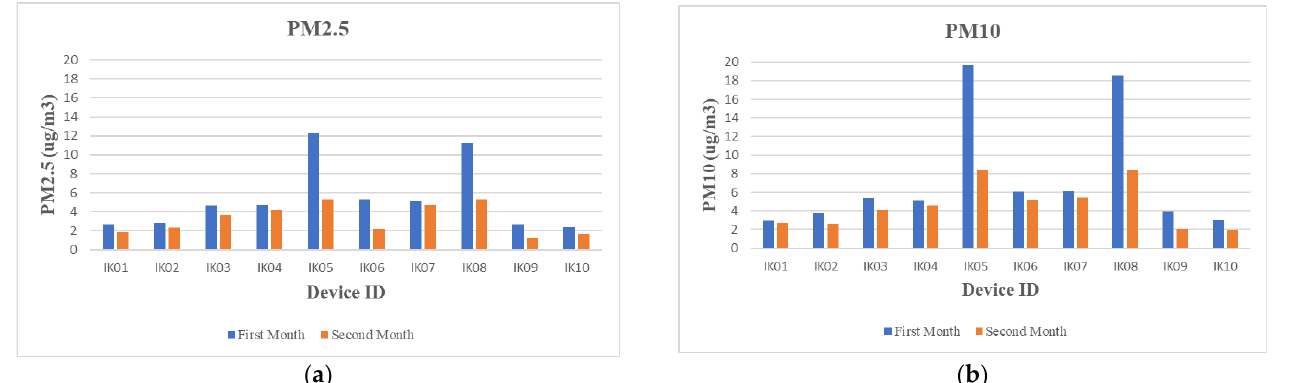
Figure 2. ( a , b ): IAQ (PM 2.5 and PM 10 ) improvement patterns from all participant households, with blue plots showing the first-month readings and the orange plots showing the second-month read- ings.